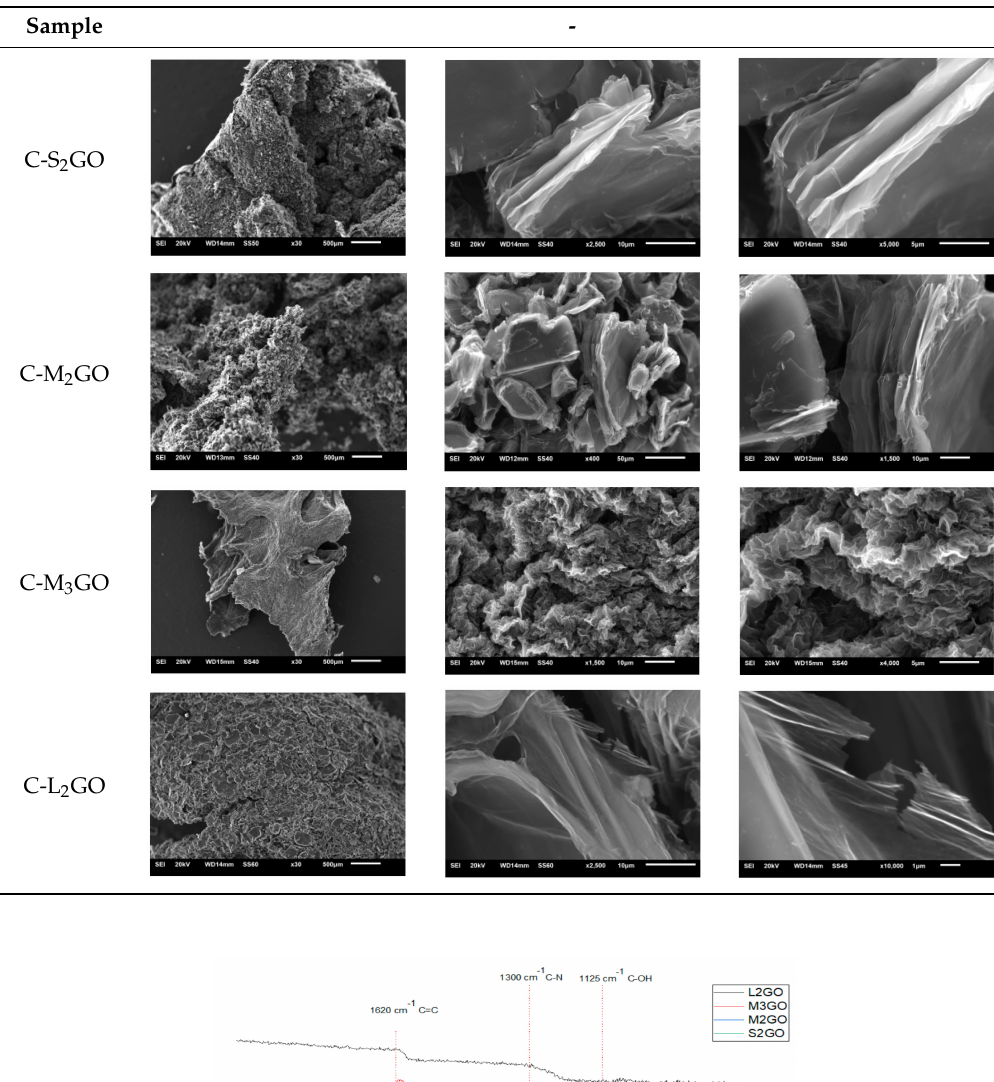
Table 4. Collection of morphology images taken with SEM microscopy of the graphene oxide powder samples treated with a cross-linking process using hydrazine.